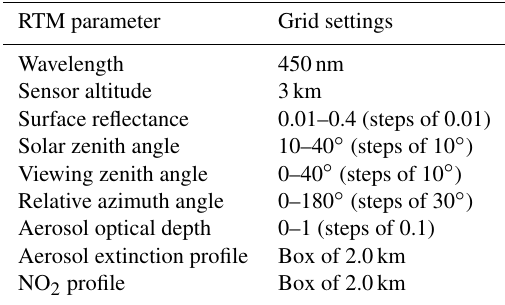
Table 4. Overview of the input parameters in the SCIATRAN RTM, characterising the AMF